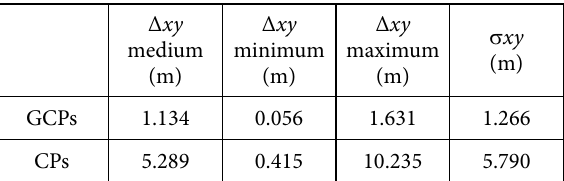
Table 3. Residuals (in meters) obtained for GCPs and CPs for Landsat 8 scene re-projection (with datum transformation) using Polynomial Functions 2nd order